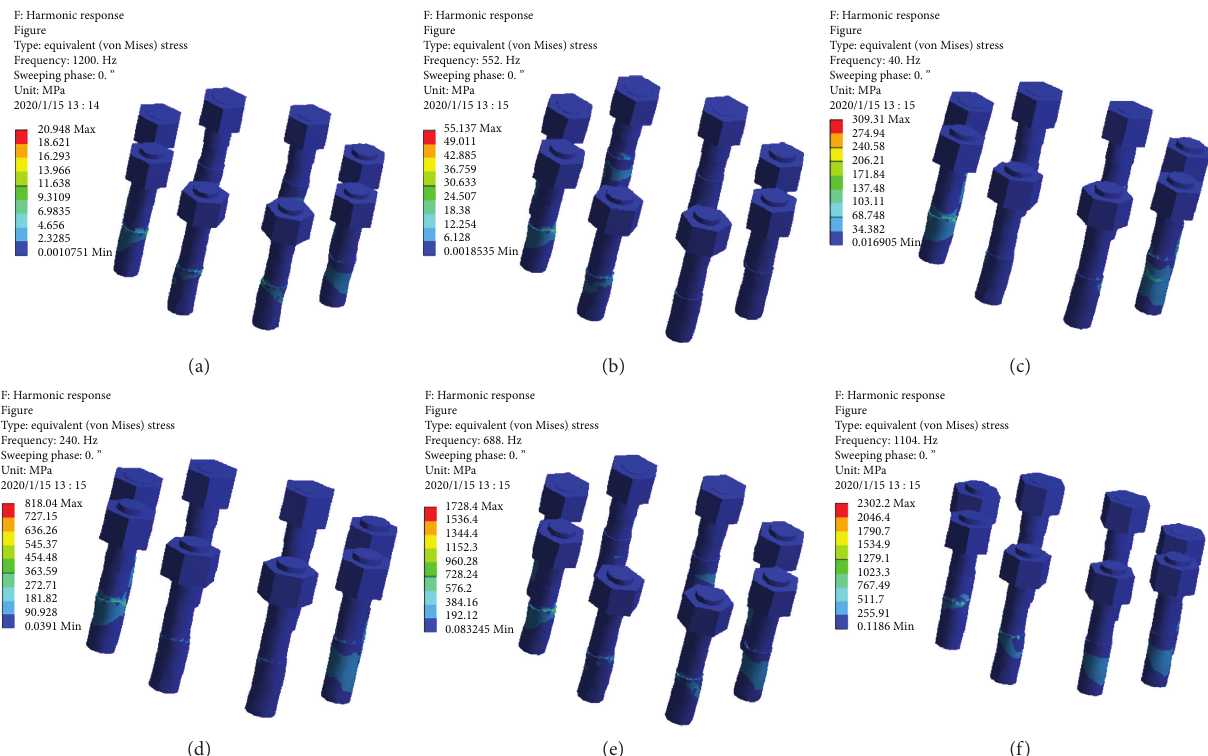
Figure 5: Stress cloud diagrams of bolts at different frequencies: (a) 1200Hz; (b) 552Hz; (c) 40Hz; (d) 240 Hz; (e) 688Hz; (f) 1104Hz.